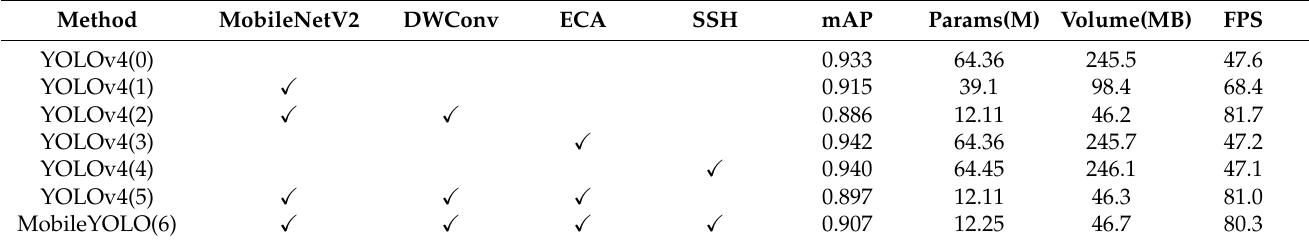
Table 3. Results of ablation experiment.